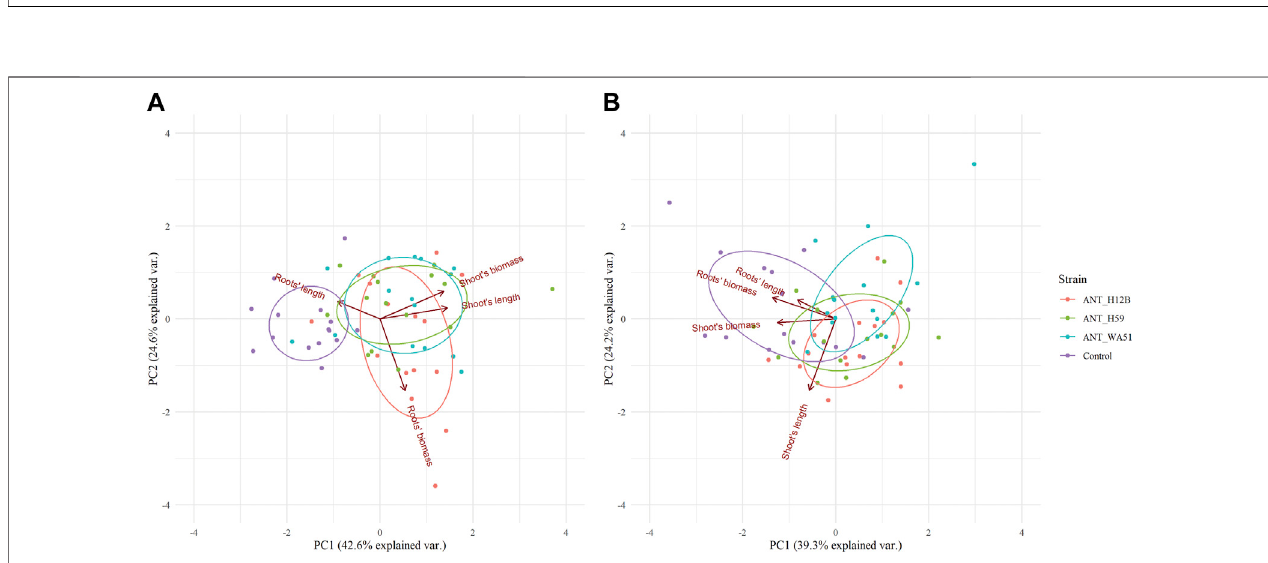
FIGURE5| Principalcomponentanalysis(PCA)ofplantmorphologicalfeaturesinreponseto: (A) inoculationwithvarioustestedbacteria; (B) supplementationwith bacterial metabolites after 21 days ofthe experiment. Particular bacterial strains used for inoculation (panel (A) ) or strain-speci fi cmetabolites (panel (B) ) are represented by uni fi ed color code. PCA eigenvectors on both panels indicate the in fl uence of each variable on principal components.